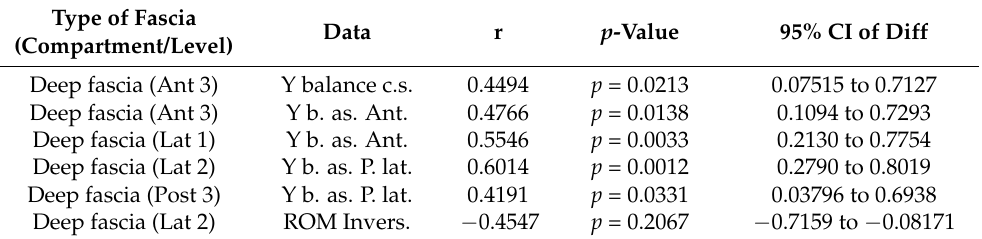
Table 6. Correlation (Pearson R coefficient test) between deep/crural fascia Ultrasound measurements and Y balance test (composite score; asymmetry), ROM within group A. Only statistically significant data are reported.